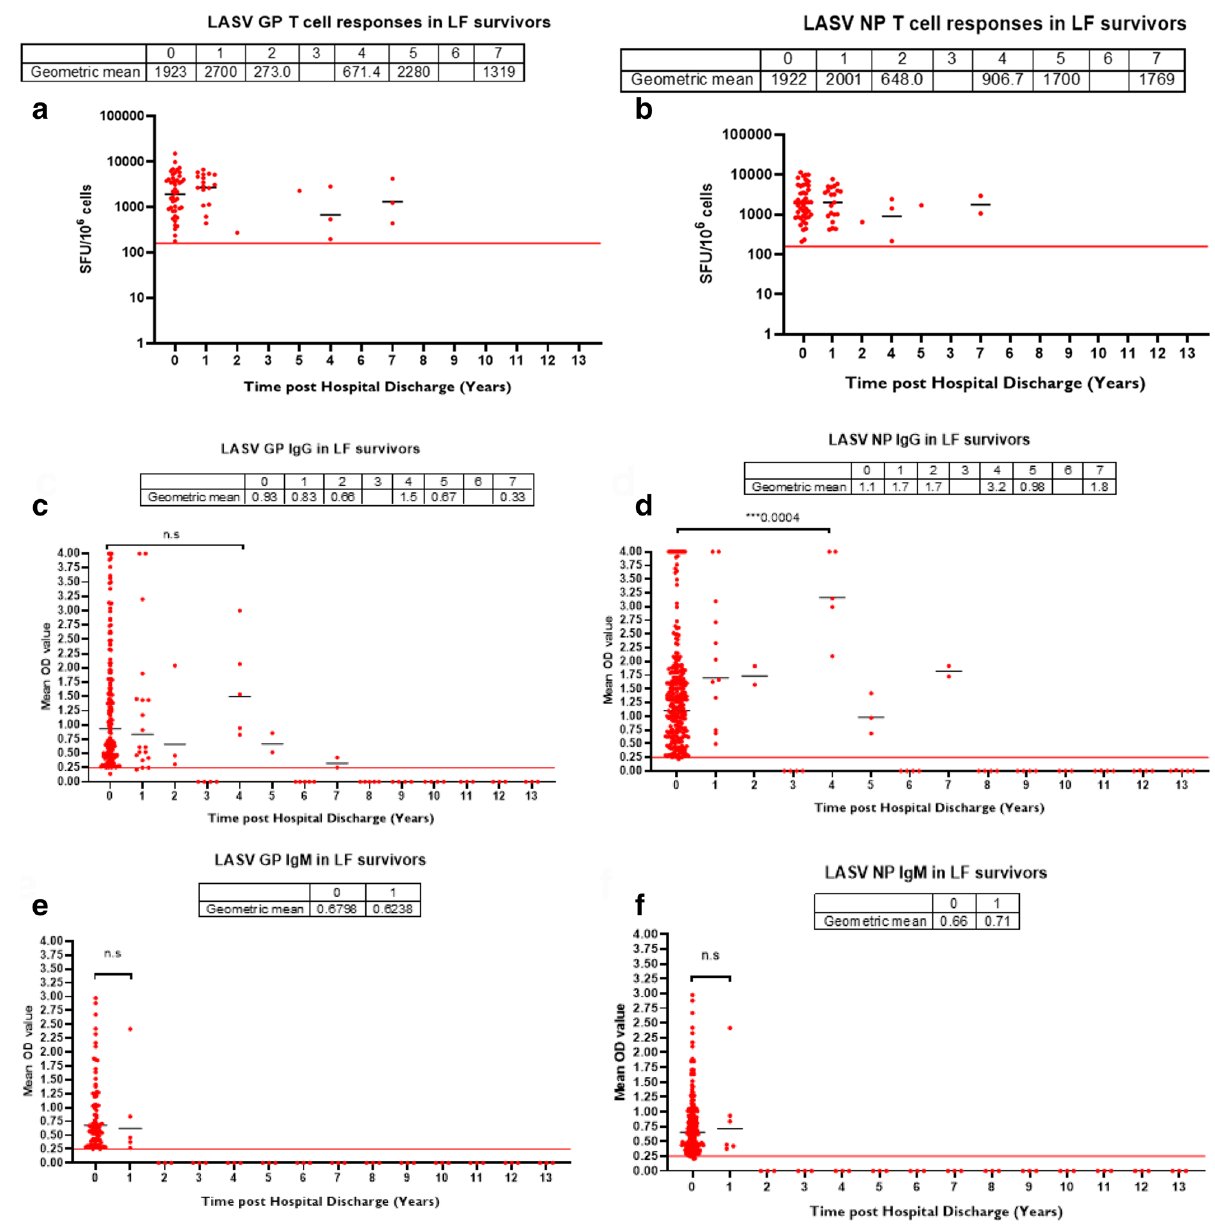
Figure 4. T cell and antibody responses to LASV wane after a decade in LF survivors. Durability of both T cell response (positive specific interferon gamma ELISpot ( a , b )) and antibody response (positive ELISA ( c – f )) was measured by subtracting the time the patient was discharged from hospital (confirmed LASV negative RT-PCR test) from the time of sample collection (time in years) over 13 years. There was no T cell response after 8 years post-hospital discharge and IgG to both LASV GP and NP waned after eight years while IgM waned after 1 year post-infection. The table shows geometric mean at 95% CI. Statistical significance was calculated by Mann– Whitney test and p values are indicated. (Capped line with * indicating